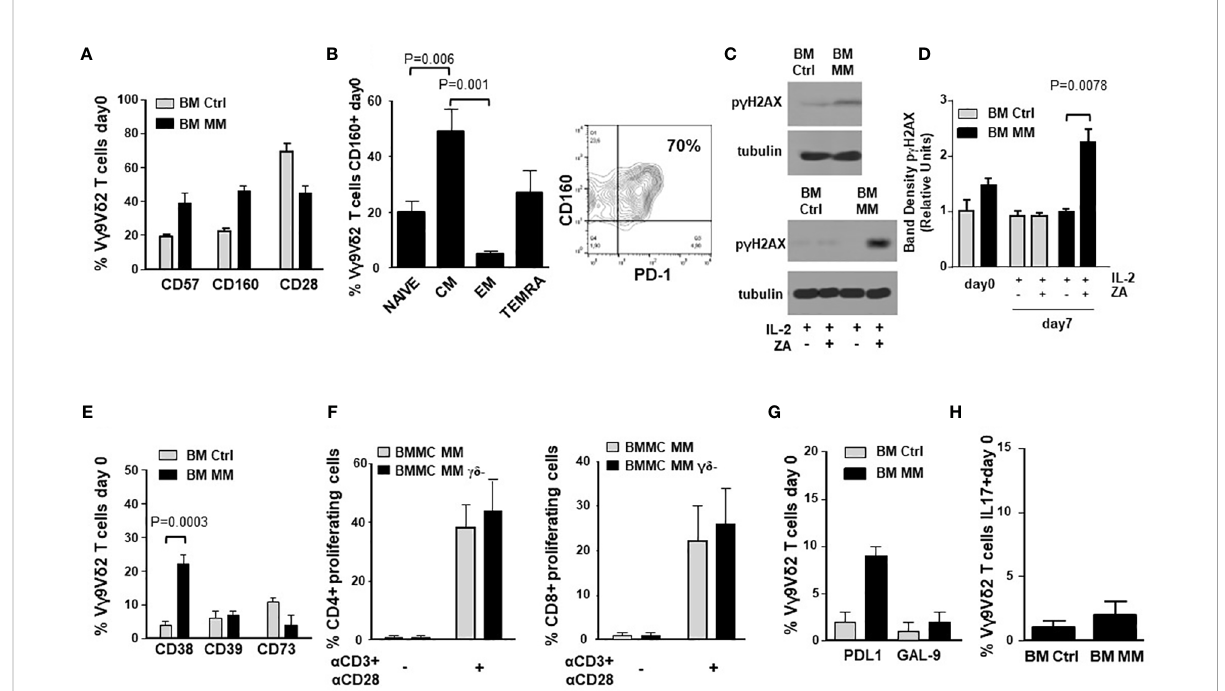
FIGURE 2 ICP expression in BM MM V g 9V d 2 T cells is associated with chronic exhaustion and immune senescence markers. (A) CD57, CD160 and CD28 expression in BM Ctrl and BM MM V g 9V d 2 T cells. Bars represent mean values ± SE from 3 (BM Ctrl) to 50 (BM MM) experiments. Differences are not statistically signi fi cant. (B) left: CM is the BM MM V g 9V d 2 T-cell subset with the highest CD160 expression. Bars represent mean values ± SE of 8 experiments; right: cyto fl uorometric analysis of CD160 and PD-1 co-expression in BM MM V g 9V d 2 T cells from one representative